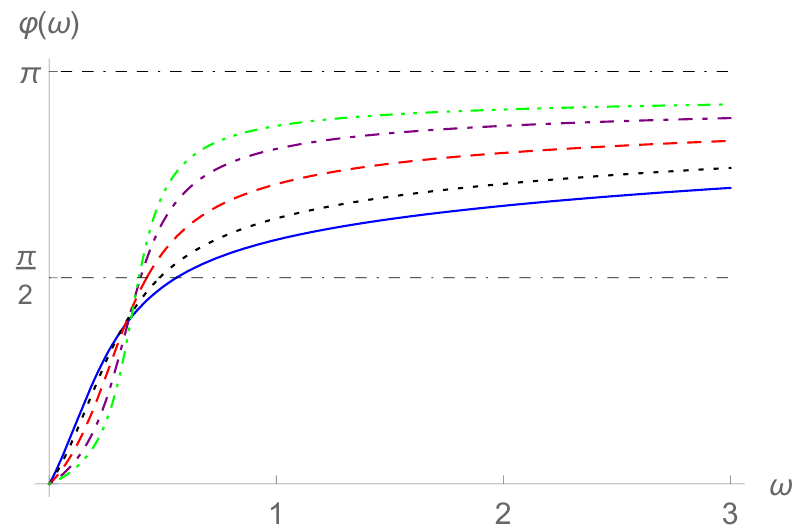
Figure 14. Frequency–phase curves ϕ ( ω ) for k = m = 1, c = 0.5, η = 5, and p = 0.01 (solid line), p = 0.1 (dotted line), p = 1 (dashed line), p = 10 (dot-dashed line), or p = 100 (dot-dot-dashed